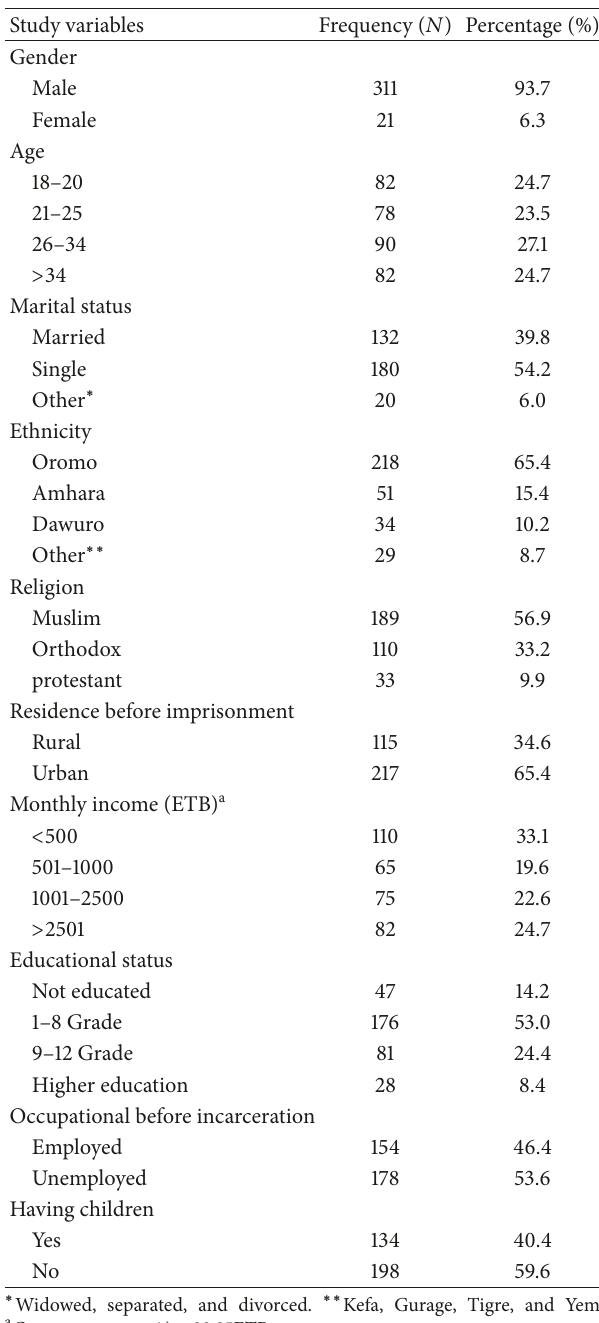
Table 1: Background characteristics of study participants